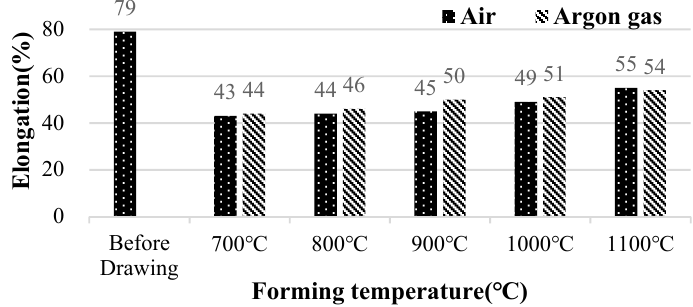
Figure 8. Comparisons of elongation of drawn wires in air and argon gas.